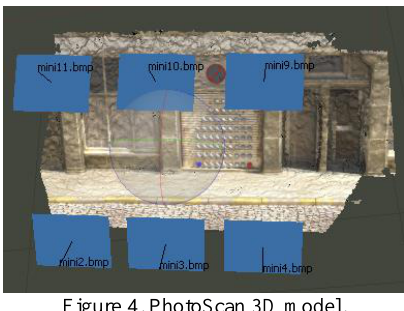
Figure 4. PhotoScan 3D model.